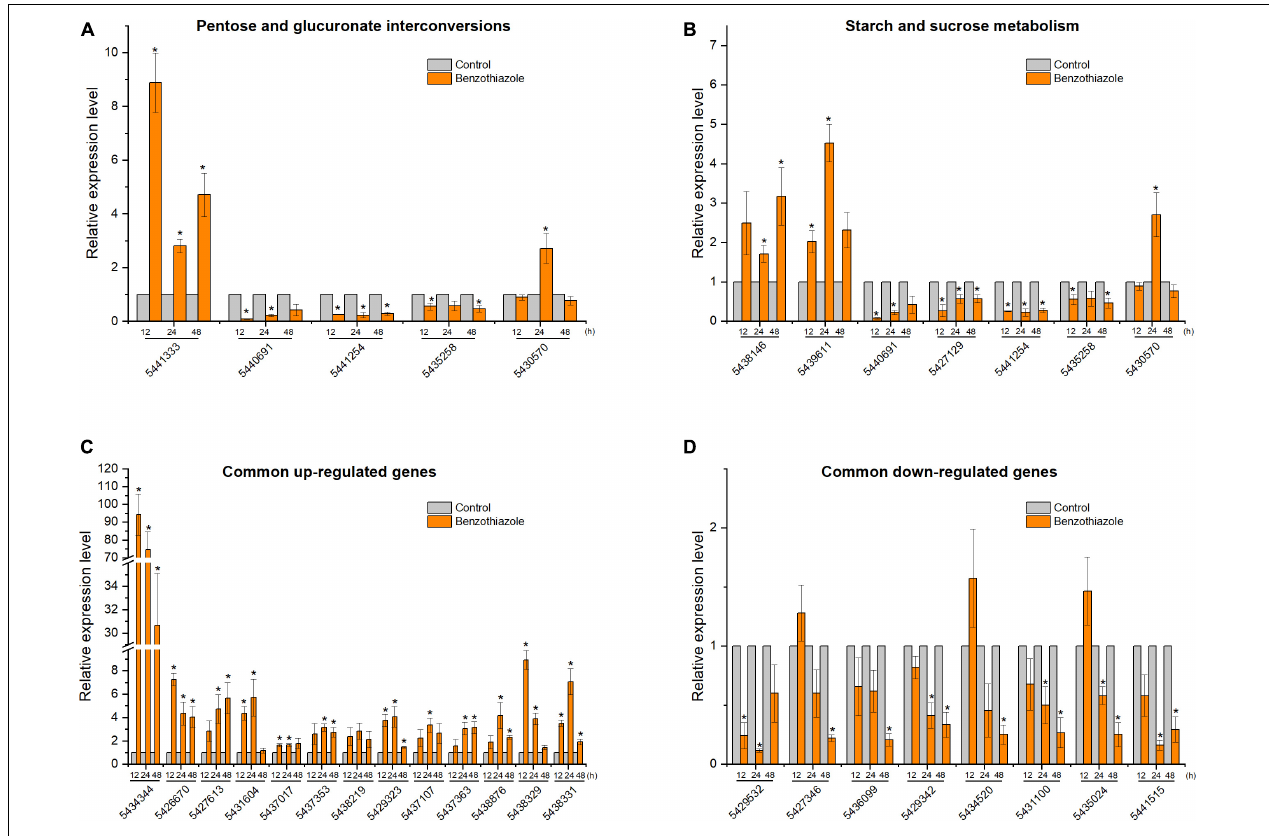
FIGURE 8 | Relative expression levels of selected DEGs in Botrytis cinerea by RT-qPCR. (A) Expression of genes participating in the pentose and glucuronate interconversions pathway. (B) Expression of genes participating in the starch and sucrose metabolism pathway. (C,D) Expression of 13 common upregulated and 8 common downregulated genes at the three time points (12, 24, and 48 h). β -tubulin was used as an internal control gene for normalization. The asterisk indicates a significant difference from the respective control.